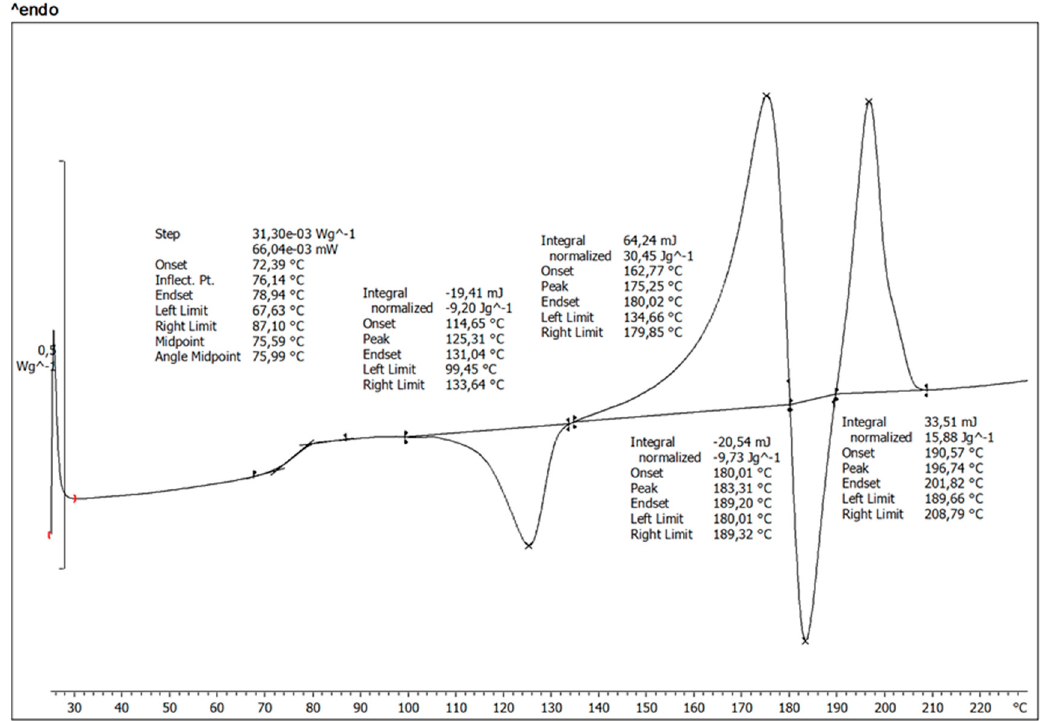
Figure 2. Thermogram of polyurethane based on isoPABA and EDA-2CL.